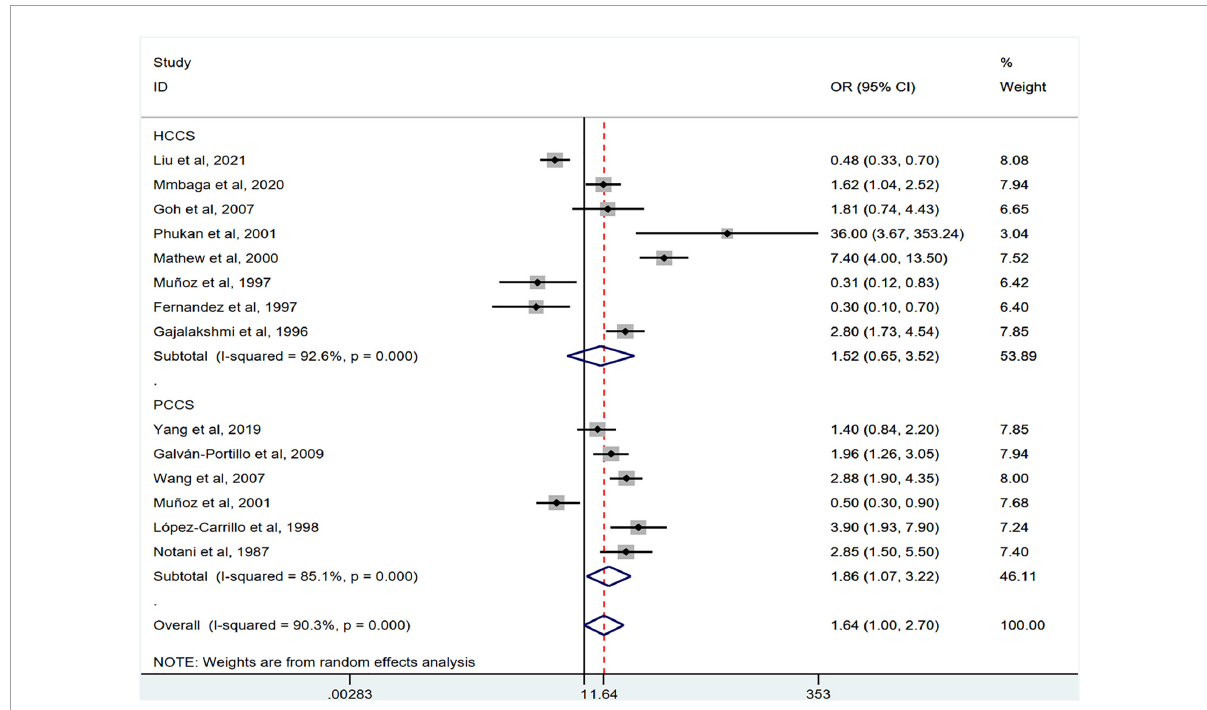
FIGURE5 Subgroup analysis showing associations between chili pepper consumption and the risk of GI cancers based on the study design. HCCS, hospital case-control study; PCCS, population case-control study; OR, odds ratio; CI, confidence